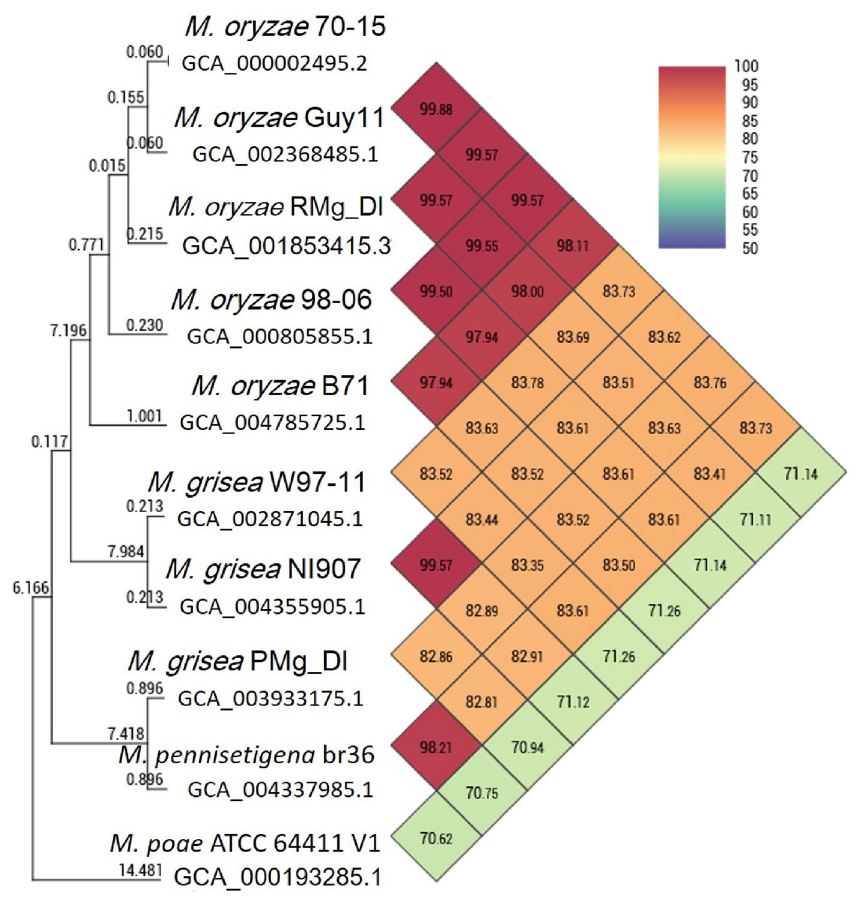
Figure 2. Average nucleotide identity (ANI) among various fungal Magnaporthe/Pyricularia genus